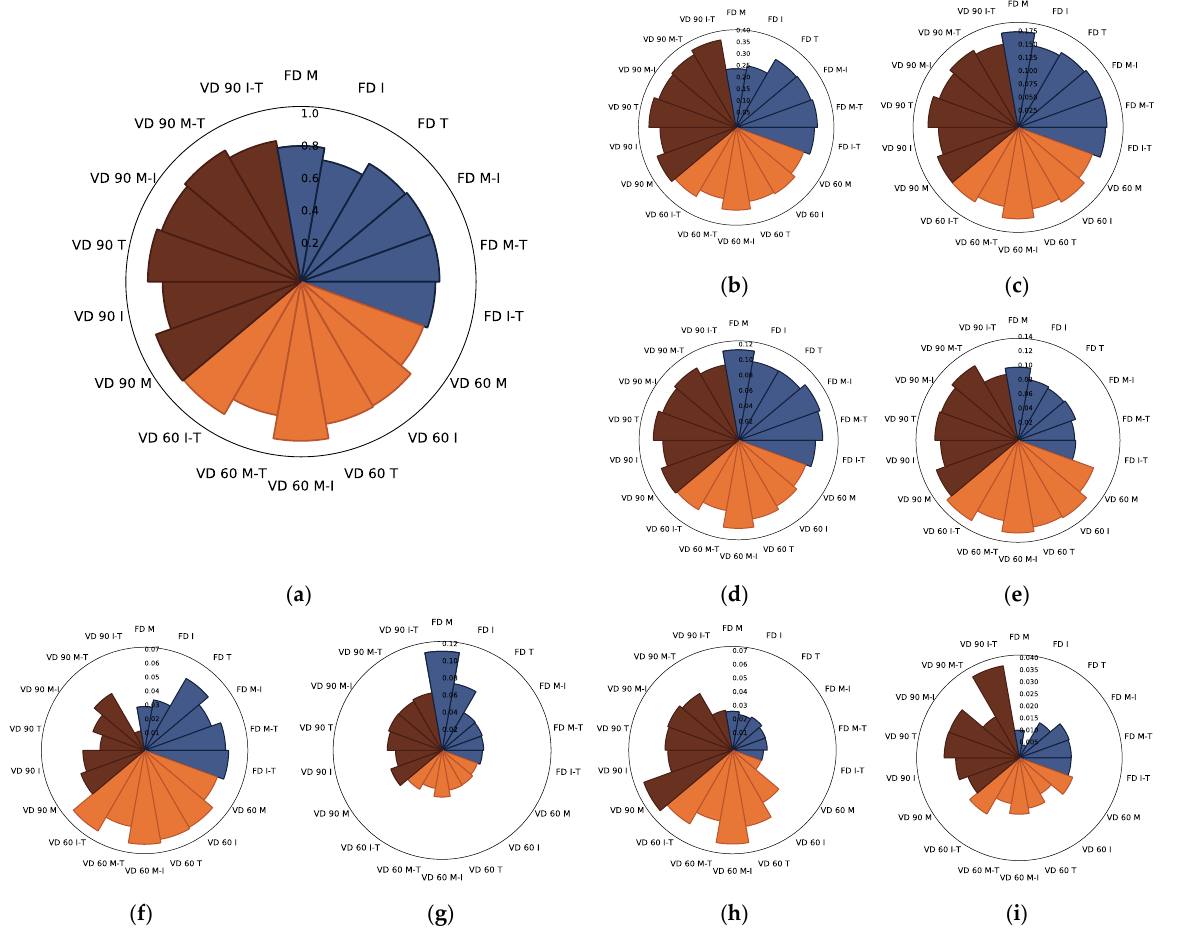
Figure 4. The radar plot of identified flavonols (( a )—sum of flavonols, ( b )—kaempferol-3- O -galactoside, ( c )—kaempferol- 3- O -glucoside, ( d )—kaempferol-3- O -rutinoside, ( e )—kaempferol-3- O -robinobioside, ( f )—quercetin-3- O -vicianoside, ( g )— quercetin-dihexoside 1, ( h )—quercetin-dihexoside 2, ( i )—derivative of quercetin) in chokeberry pomace extract powders gained with addition of maltodextrin (M), inulin (I), trehalose (T), maltodextrin—inulin (M—I), maltodextrin—trehalose (M—T) and inulin—trehalose (I—T) by freeze drying (FD) and vacuum drying at 60 (VD 60) and 90 ◦ C (VD 90) ( n = 2) (g/100 g